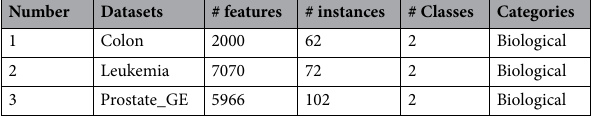
Table 9. High-dimensional datasets and their properties.